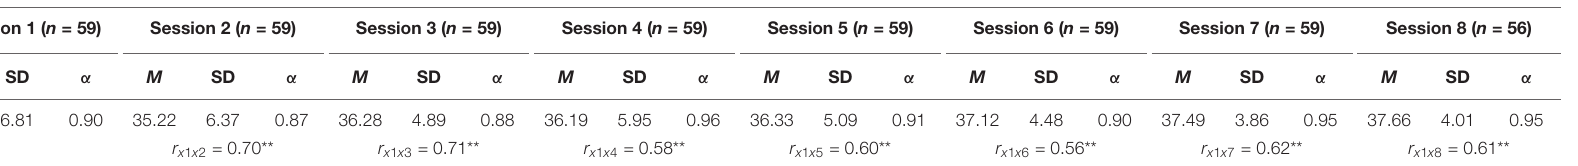
ORS, Spanish-Language (SL) Outcome Rating Scale; SRS, SL Session Rating Scale. **p < 0.01 (two-tailed); *p < 0.05